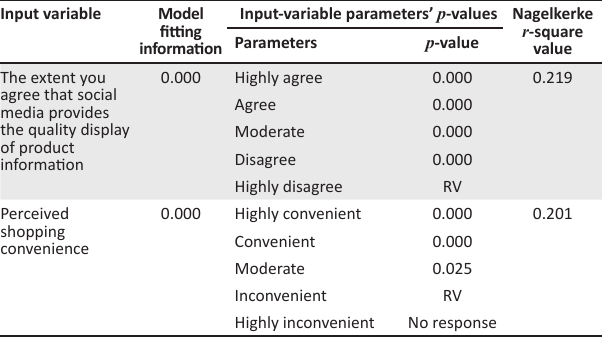
TABLE 5: Determinants of the perceived relevance of social commerce with all parameters with a significant p -value. Input